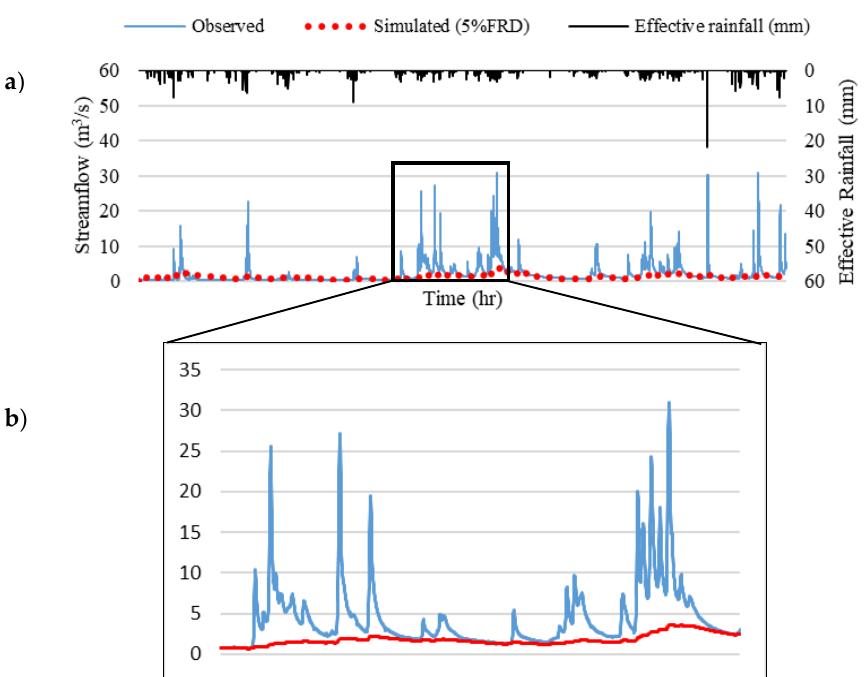
Figure 7. ( a ) Validation of the calibrated 5%-FRD model; ( b ) zoomed in for a clear view.